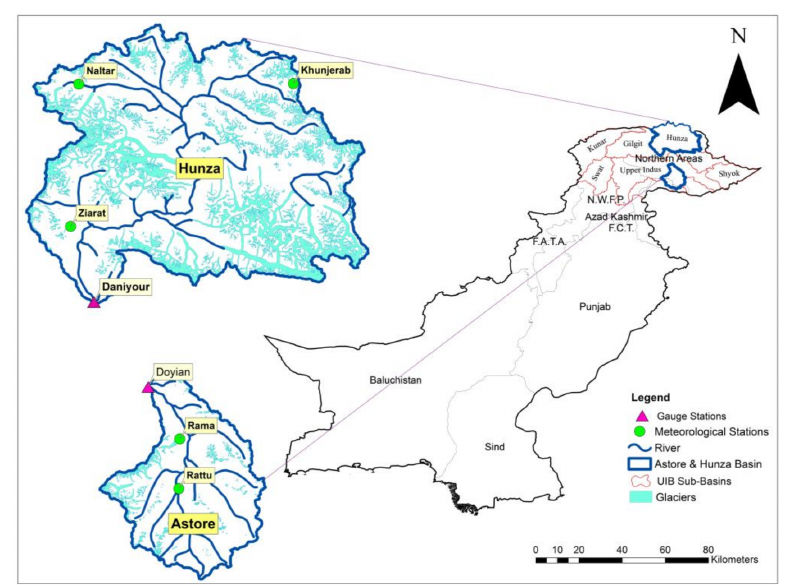
Figure 1. Map of the study area showing the Hunza and Astore sub-basins of the upper Indus Basin along with the glaciers. The glaciers’ boundaries were delineated from the LANDSAT 7 ETM+ using the Normalized Difference Index (NDSI), Slope, Aspect, Normalized Difference Vegetation Index (NDVI) and Land Water Mask (LWM)